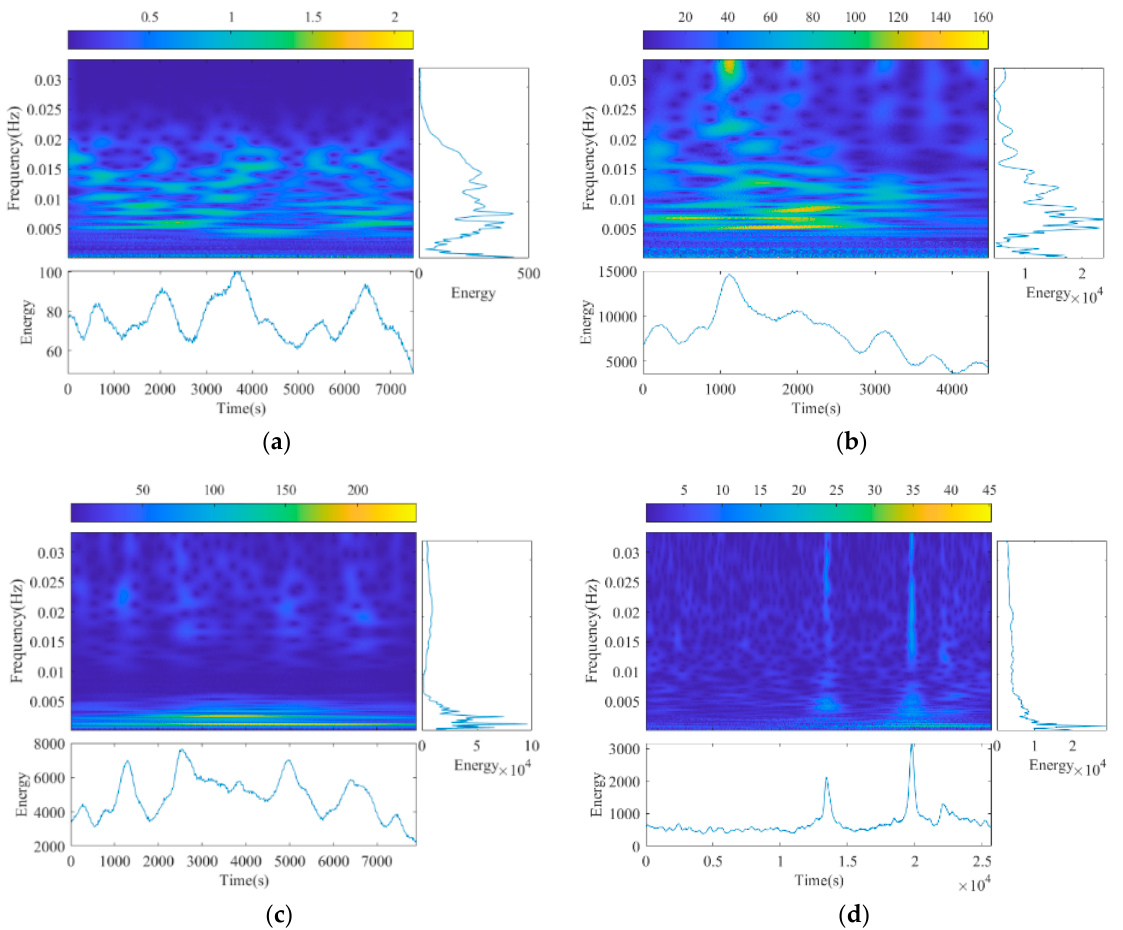
Figure 8. Time-frequency plane of EMR signals. ( a ) Environmental noise. ( b ) Drilling. ( c ) Scraper loader. ( d ) Danger signal.